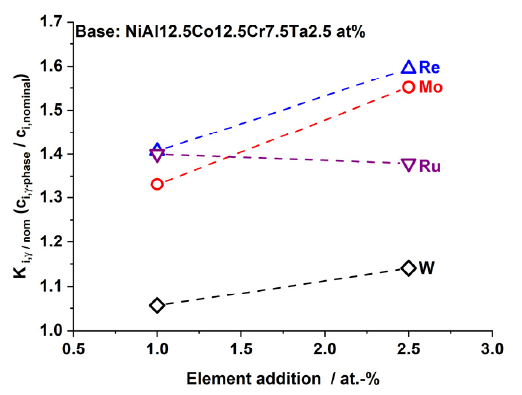
Figure 4. Partitioning behavior of solid solution strengthening elements in the polycrystalline EXP alloy series described by the partitioning efficiency.